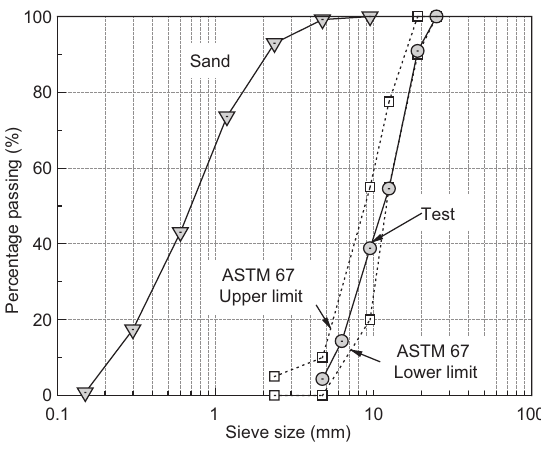
Figure 2 Aggregate size distribution.